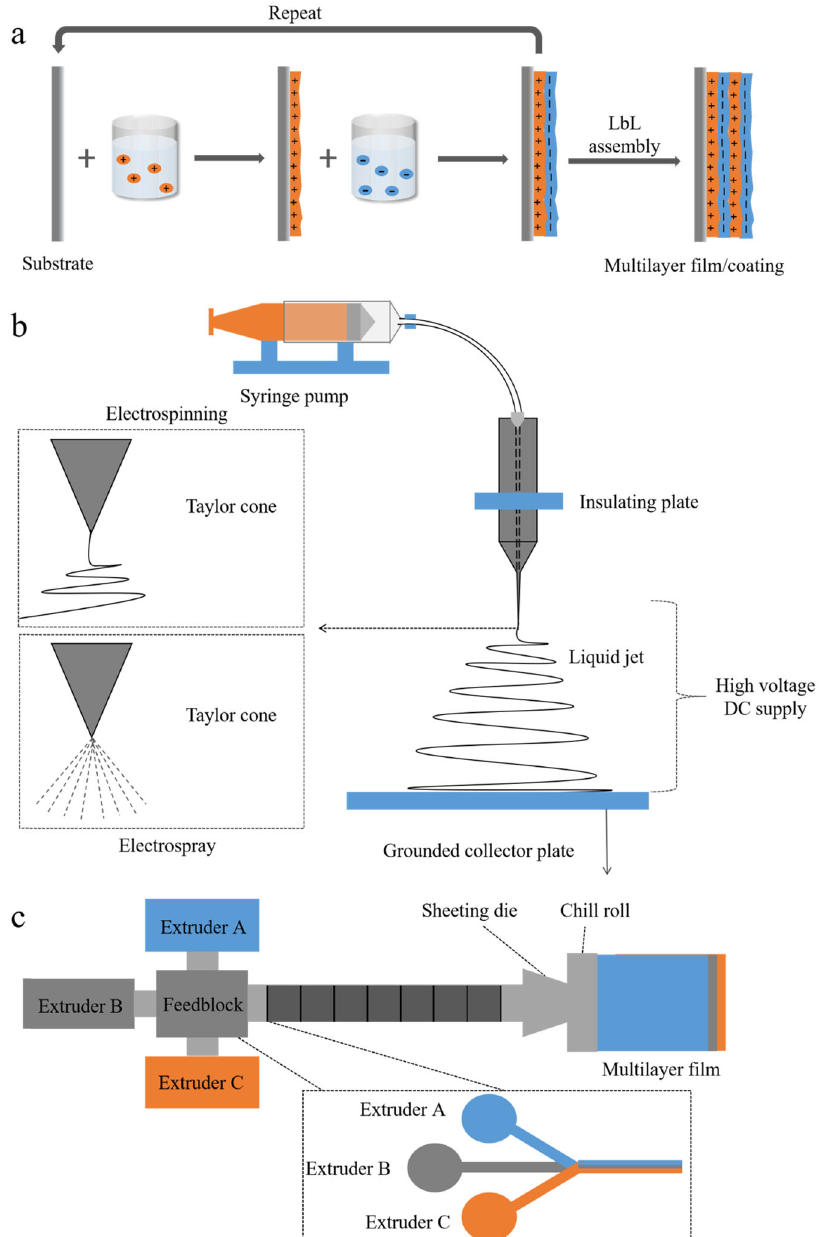
Fig. 2 Preparation of multilayer edible fi lms. a Electrostatic layer-by-layer (LbL) deposition. b Electrospinning or electrospraying. c